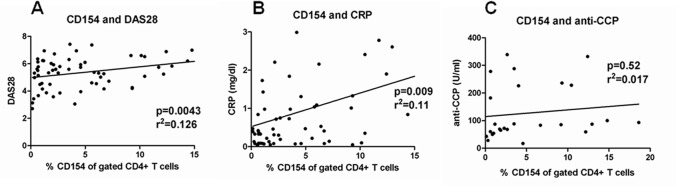
Association between the CD154 expression and the clinical parameters in RA patients.The correlation between the CD154 expression levels (% CD154 of gated CD4+ T cells measured by flow cytometry) and the levels of RA disease activity index DAS28 (A), inflammatory marker CRP (B) and anti-CCP autoantibody (C) in RA patients. CRP: C-reactive protein; anti-CCP: anti-cyclic citrullinated peptide antibody.